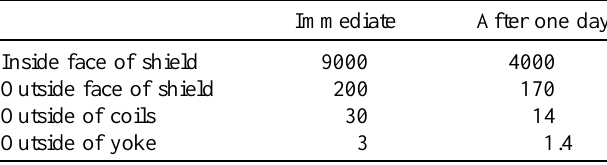
TABLE XIV. 4 TeV (COM) collider ring radioactivation levels (mrem (cid:1) h) after turn-off, for parameters in Table